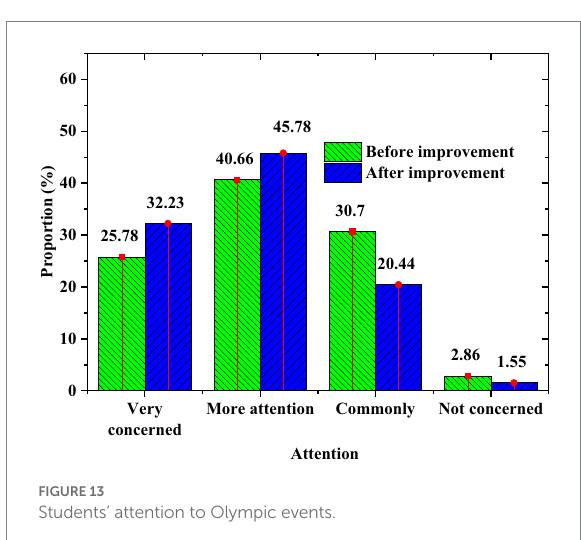
FIGURE 12 Students’ mastery of knowledge.